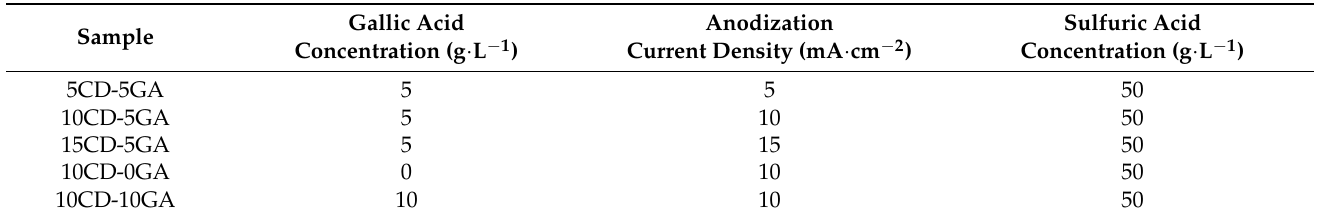
Table 1. Summary of experimental conditions used for the anodization runs in the study.